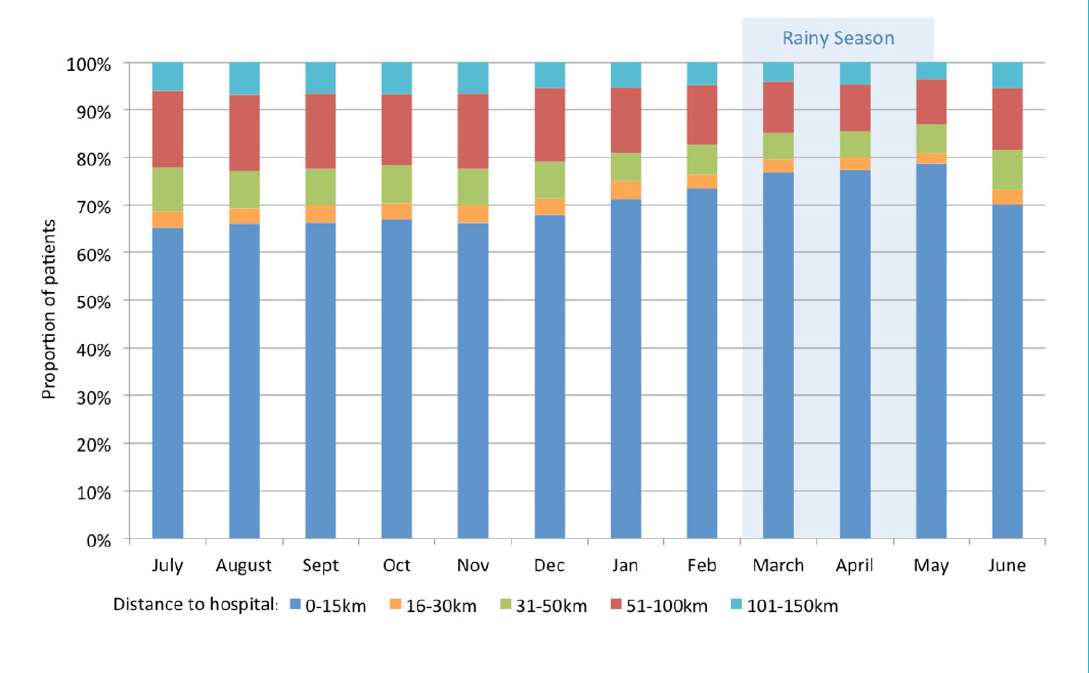
Figure 1: Distribution of patients according to distance home to hospital. Bars represent monthly proportions of emergency department pa- tients with respect to distance from home to the hospital. The rainy season is marked in blue (March-May).